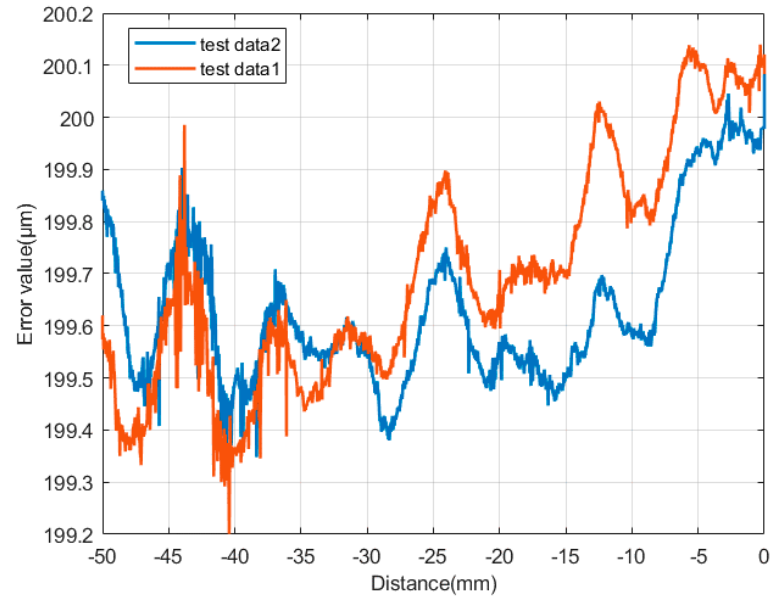
Figure 4. Straightness of the X ‐ axis guide.